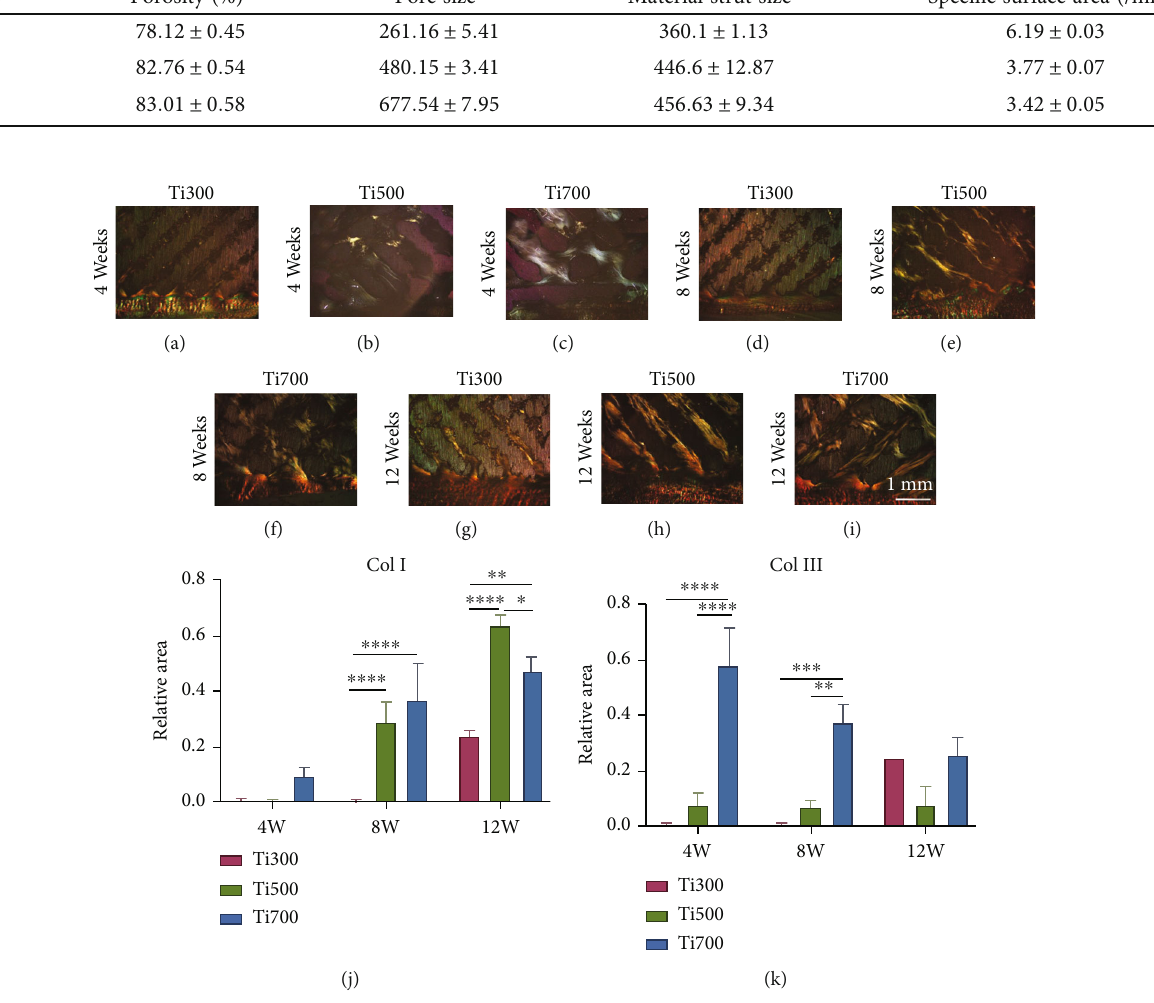
Table 1: Porosity and microfocus X-ray computed tomography-based three-dimensional structural analysis.